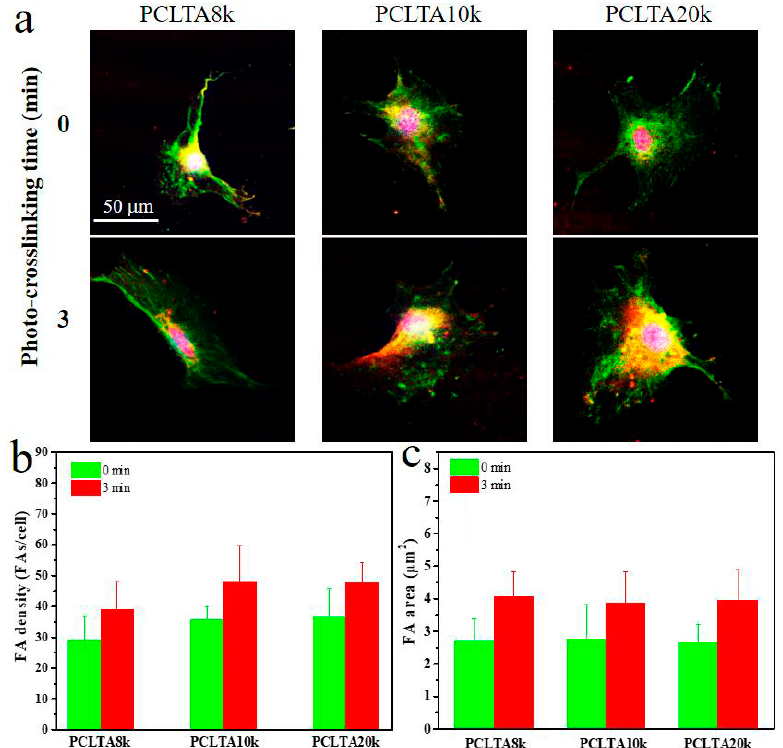
Figure 7. Characterizations of focal adhesions (FAs) in SMCs at day 1 post-seeding on PCLTAs with different crosslinking time (0, 3 min). ( a ) Immunofluorescence images of FAs in the cells with vinculin stained green, and F-actin stained red. Scale bar of 50 μ m is applicable to all. Quantification of FAs in terms of ( b ) FA density, and ( c ) FA area.